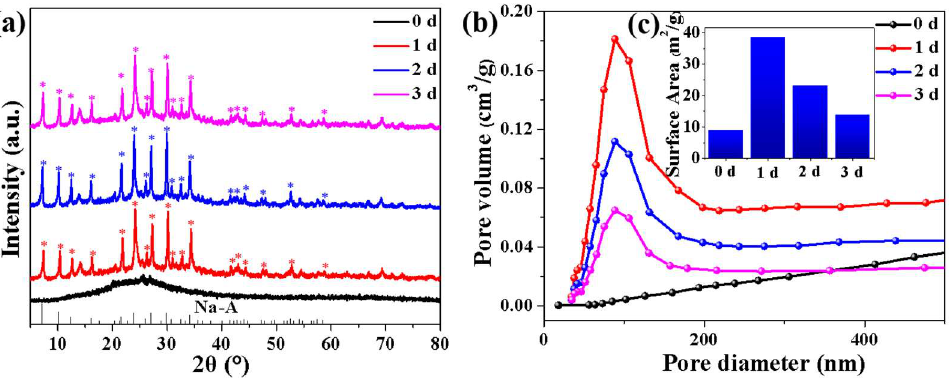
Figure 2. XRD test and BET test of NMGM catalyst with Na 2 O/SiO 2 of 0.8 at hydrothermal time of 0 d, 1 d, 2 d, 3 d: ( a ) XRD (*: characteristic peaks of NaA molecular sieves), ( b ) pore-size distribution, ( c ) specific surface area.